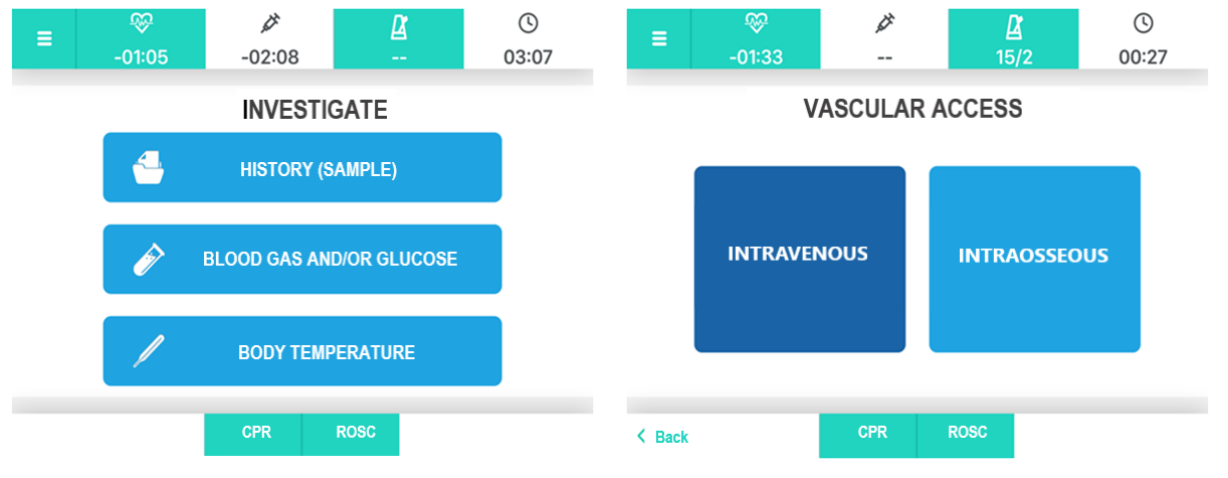
Figure 1. Sequential versus alternative choices. CPR: cardiopulmonary resuscitation; ROSC: return of spontaneous circulation.